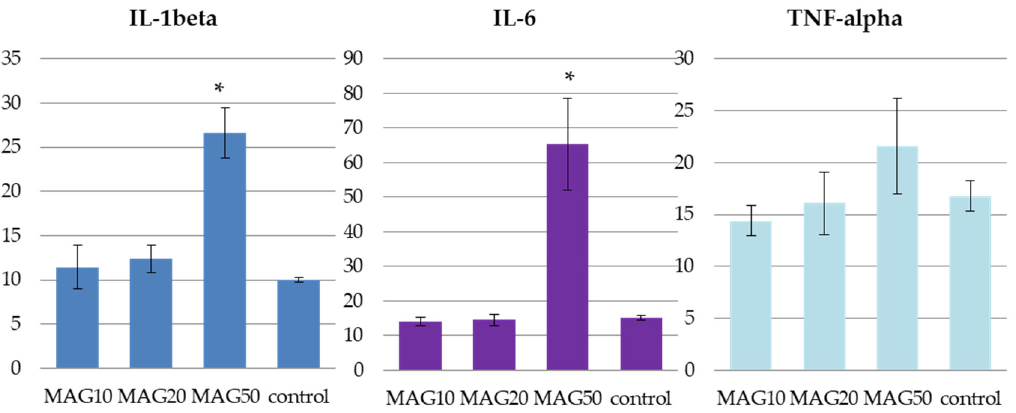
Figure 9. The average levels of IL-1beta, IL-6, and TNF-alpha in pg/mL of plasma of the three tested